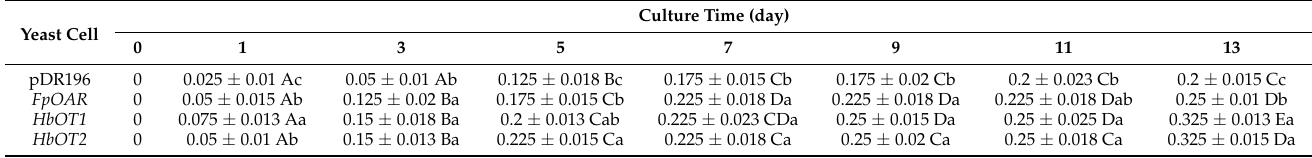
Note: Different uppercase letters show significant differences in treatment time, and different low- ercase letters imply significant differences in yeast transformants ( p < 0.05), the same in the following Table 3. Variation of dry weight for yeast transformants containing pDR196 empty vector (negative control), FpOAR (positive control), HbOT1 , and HbOT2 under 13 days’ 2 mmol/L oxalic acid stress. (g). Culture Time